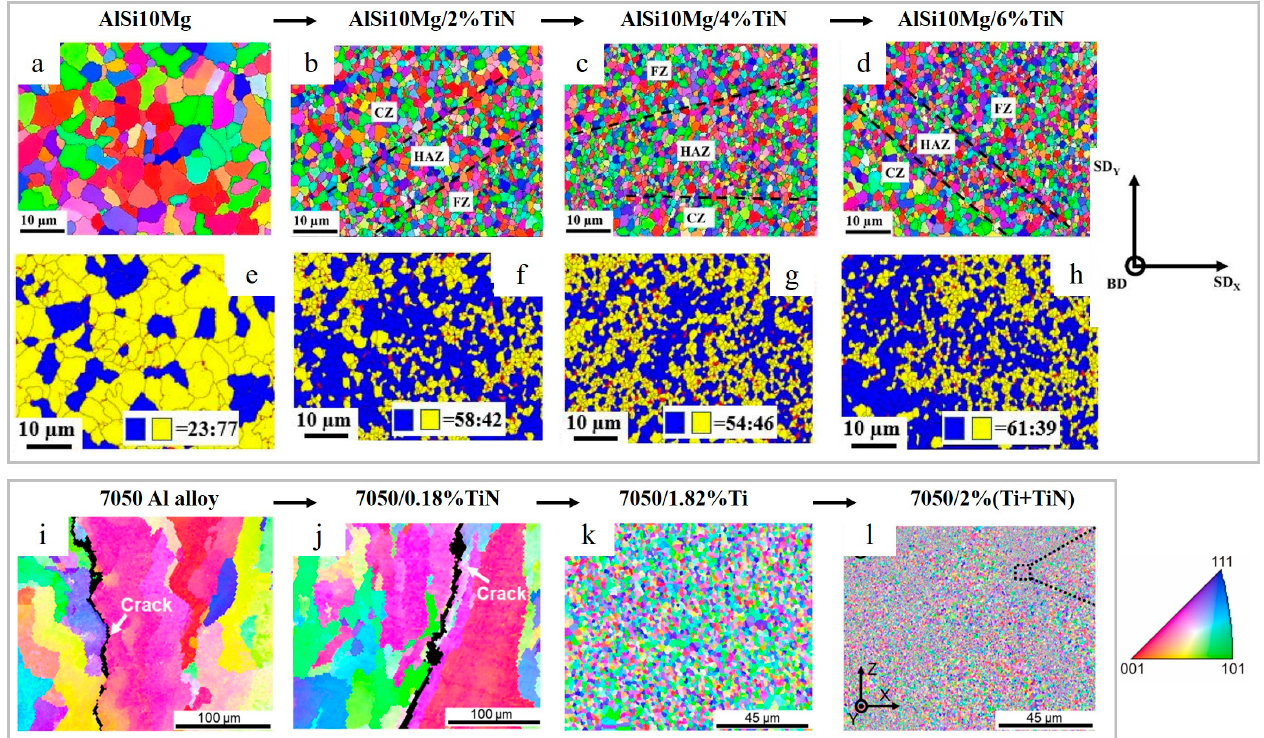
Figure 19. EBSD orientation maps from the top view and distribution of sub-structured (in yellow) and recrystallized (in blue) grains of the as-built AlSi10Mg reinforced with 0% TiN ( a , e ), 2%TiN ( b , f ), 4% TiN ( c , g ) and 6%TiN ( d , h ) EBSD color maps of 7050 Al alloy ( i ), 7050-0.18TiN ( j ), 7050-1.82Ti ( k ) and 7050-2(Ti+TiN) ( l ) (reproduced with permission from [66,101]).